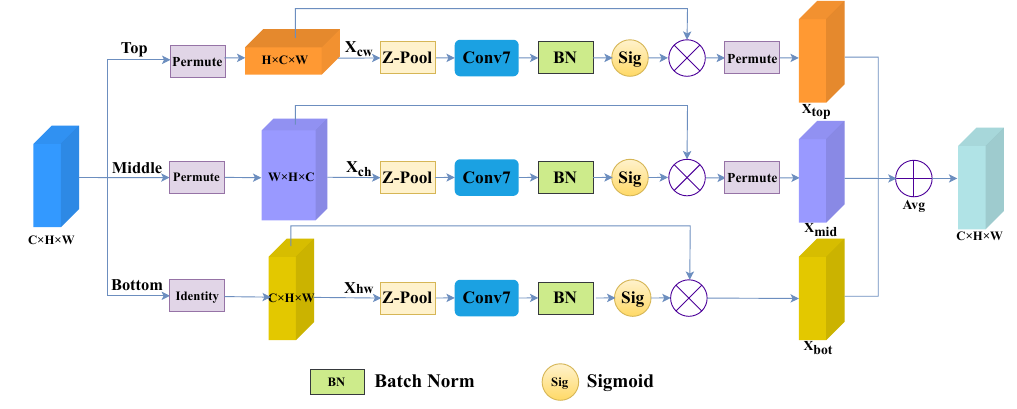
Figure 3. Architecture of the TVA